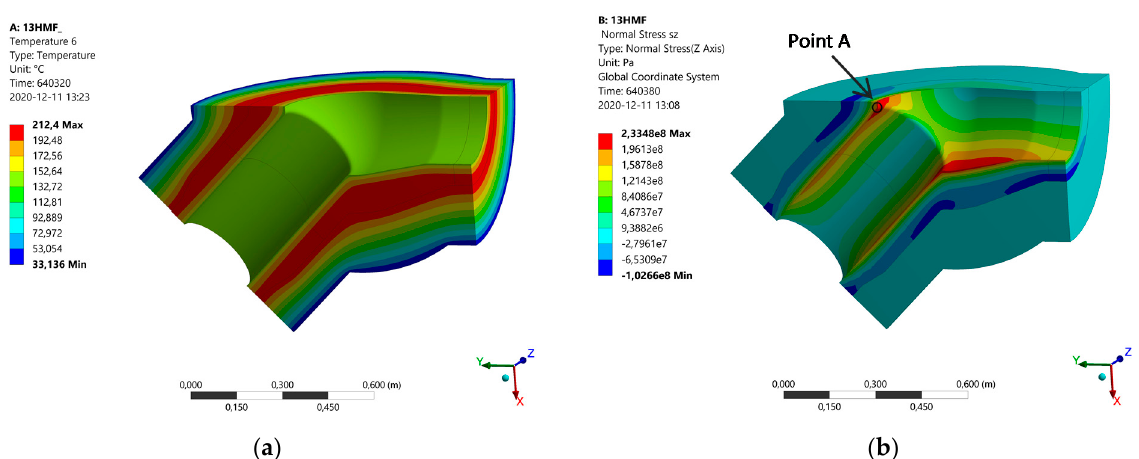
Figure 14. Exemplary models of the distributions of temperature and the normal component z of the stress tensor at selected times: ( a ) 640,320 s, and ( b ) 640,380 s.